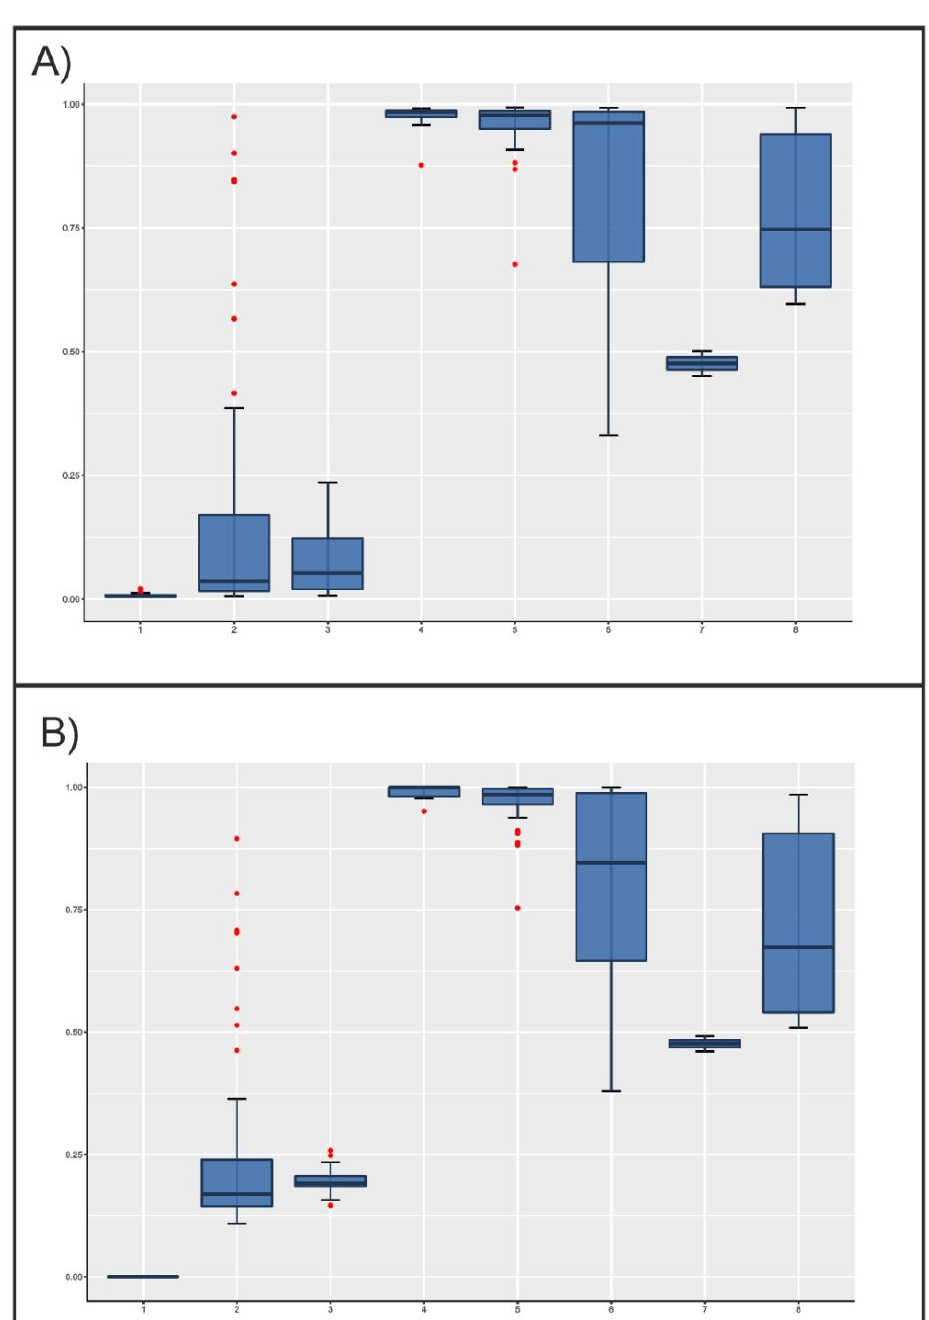
Figure 2. Boxplots illustrating the variation of individual admixture coefficient, 𝑞̂ q , estimated using microsatellites (Plot A ) and SNPs (Plot B ), by cattle population assuming K = 2. The box represents the range that contains the values within the limits of the standard error of the mean, the line within the box indicating the mean value. The whiskers are the lines that extend from the box to the standard deviation excluding outliers. Outliers, which are represented by red dots, are values that are 1.5–3 standard error lengths from the upper or lower edge of the box. Numbers on the X -axis mean the following: (1) Lagunaire; (2) N’Dama (Burkina Faso); (3) N’Dama (Congo); (4) Zebu Peul (Benin); (5) Zebu Peul (Burkina Faso); (6) Borgou; (7) Lobi; and (8) Zou. Populations from 1 to 3 belong to West African taurine cattle, populations 4 and 6 belong to West African zebu cattle, and populations from 6 to 8 belong to sanga cattle.